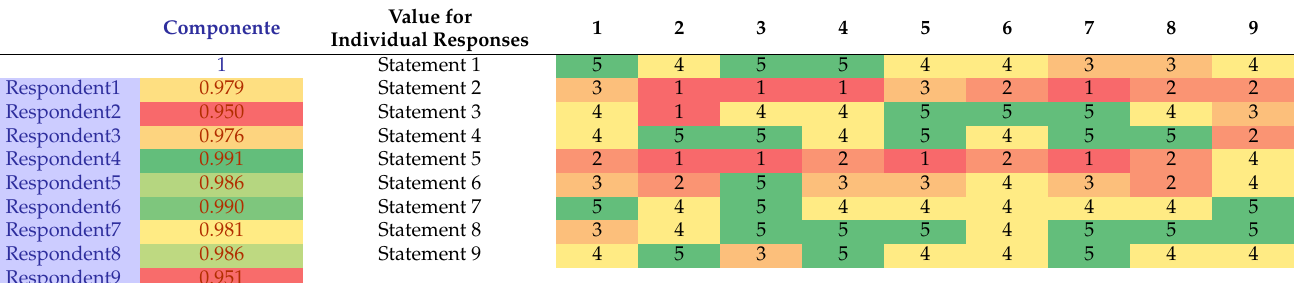
Table 2. Q-analysis results of nine energy “brokers” on nine distinct critical energy